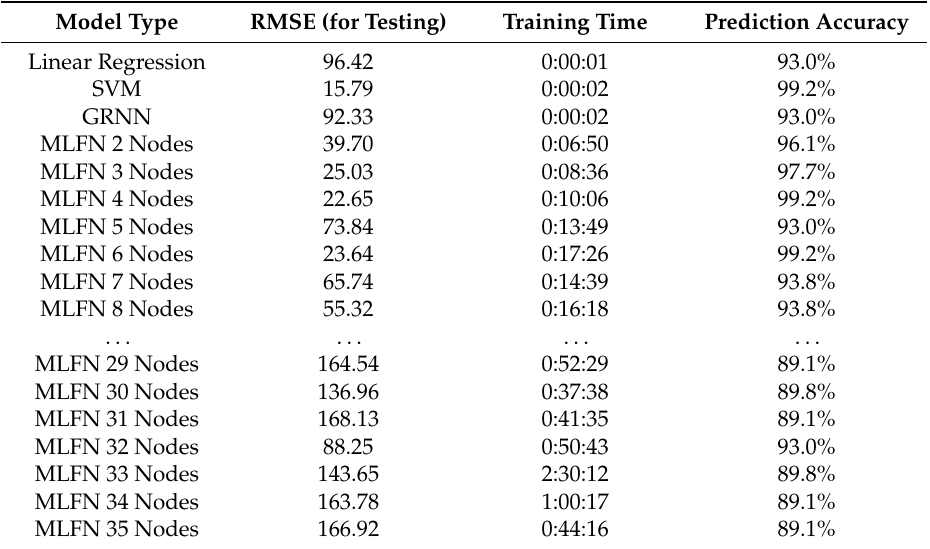
Table 4. Prediction models using experimental data by all the three experiment reports [1,24,25]. Model Type RMSE (for